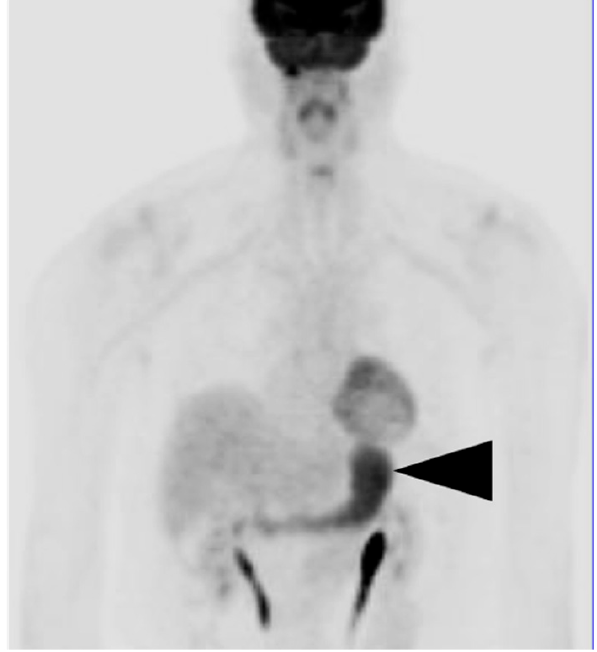
Figure 7. Physiological gastric uptake of FDG. Anterior FDG PET MIP image shows diffuse metabolic activity throughout the stomach (black arrowhead), This is nonspecific and may be related to gastritis or physiological or unknown factors. Tumor cannot be excluded. If this is an incidental finding, endoscopy is recommended if the patient has gastric symptoms.